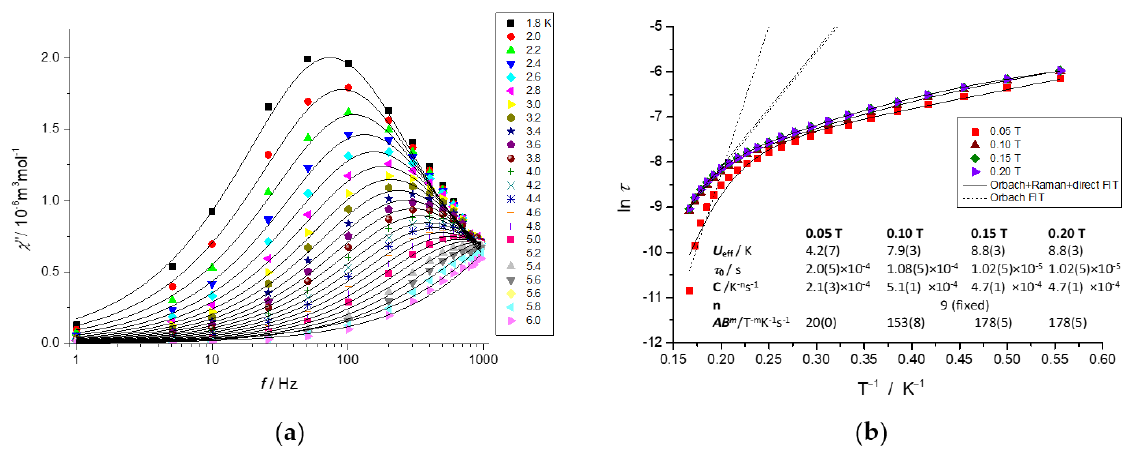
Figure 5. ( a ) Frequency dependent out-of-phase χ ″ components of AC susceptibility for compound II recorded at the applied static magnetic field B DC = 0.05 T (Solid lines present fits using the one-component Debye’s model, Equations (S1) and (S2); see Supplementary Materials); ( b ) The ln τ vs. 1/ T dependency obtained from AC susceptibility measurements at four static magnetic fields.